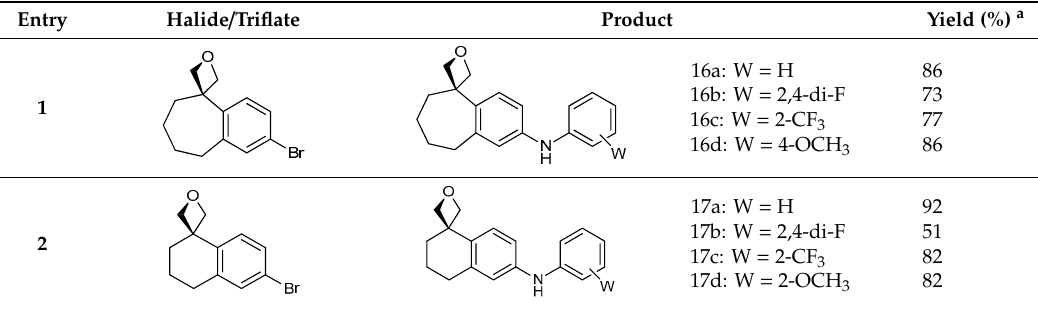
Table 1. N -arylamine oxetanes obtained via Buchwald–Hartwig Reaction.